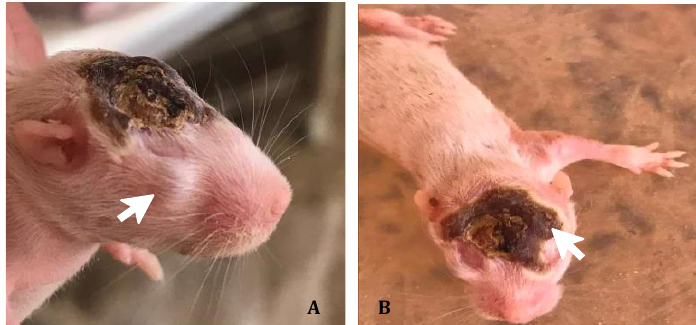
Figure 3. Photographs of rat pupies from carvedilol-methotrexate combination group, showing blindnes ( A ), skull defect and ulceration ( B )